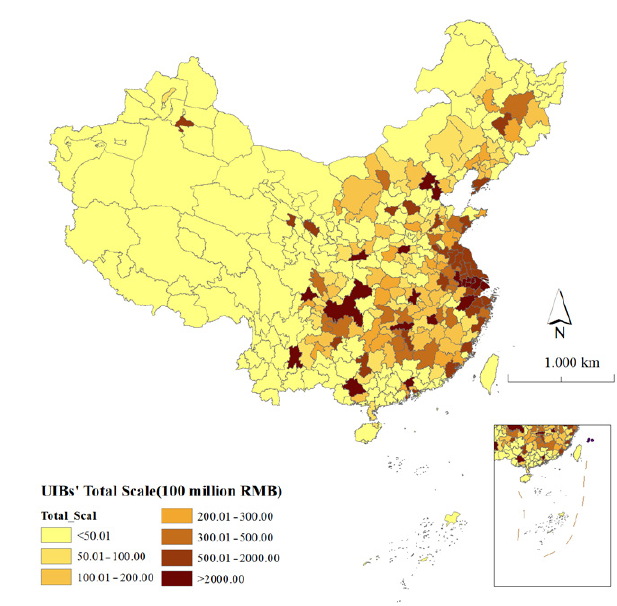
Figure 2. Total amount of UIBs issued in 289 cities from 2007 to 2018